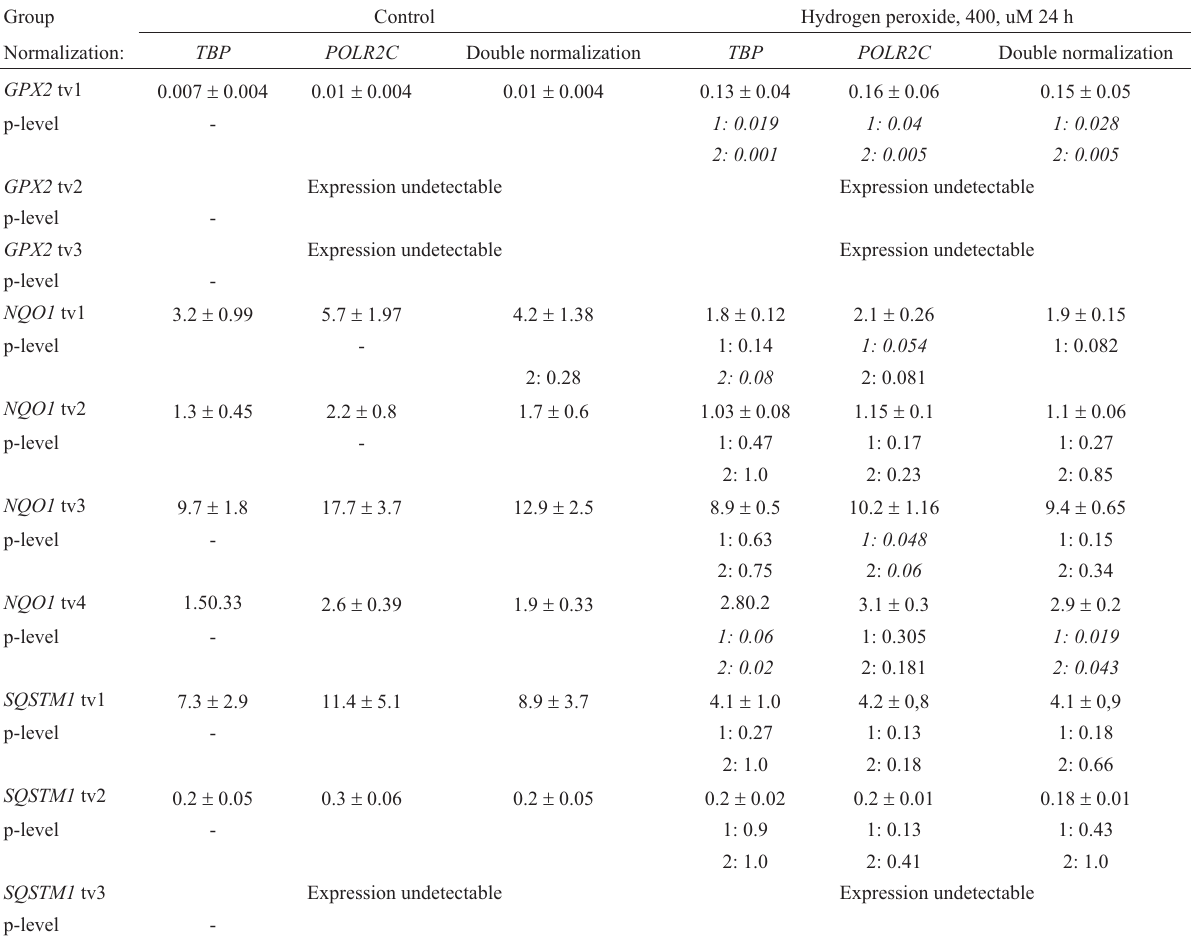
Table 2 - Expression of the GPX2 , NQO1 , SQSTM1 transcript variants in control cells and in HeLa cells treated with 400 uM of hydrogen peroxide.